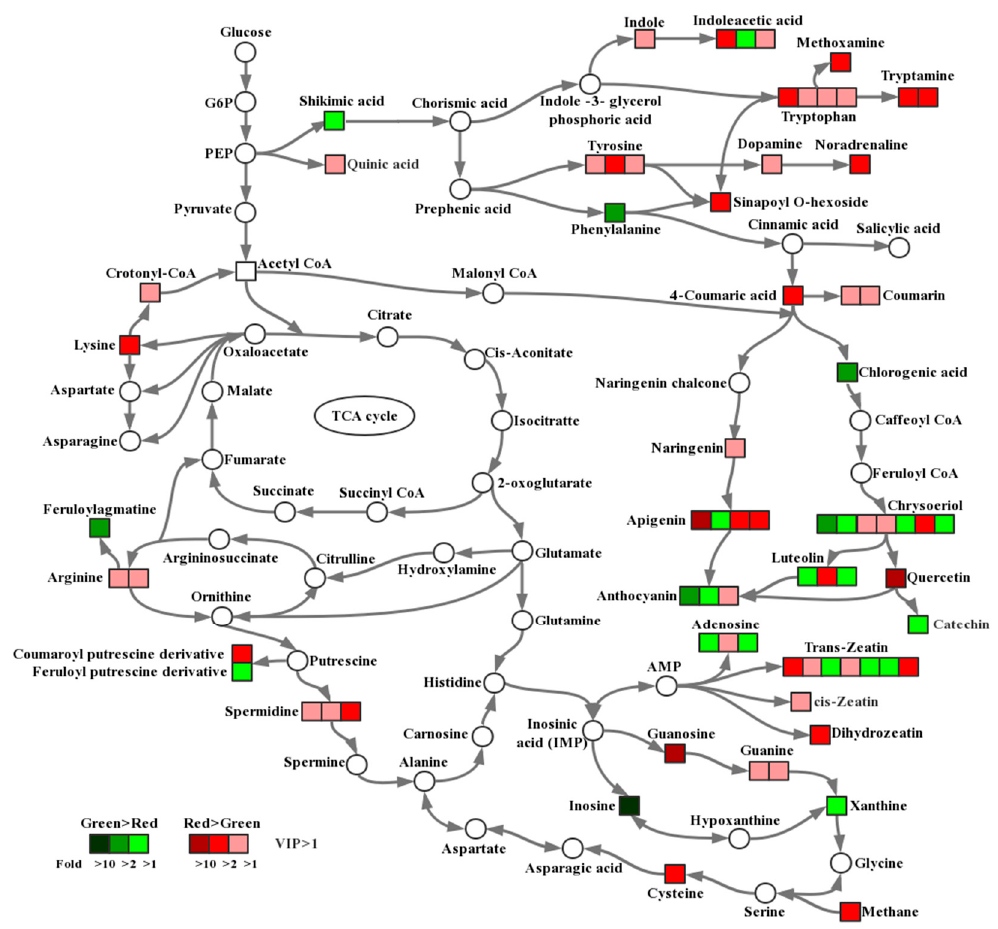
Figure 4. Comparison of metabolite accumulation in different pathways between green and red pods. Significant metabolite changes (VIP > 1) observed in red pods versus green pods are shown in the metabolic map. Metabolites shown as squares were detected in this study, whereas those shown as circles were undetectable. The squares in red indicate that the content of the metabolite in red pods was higher than that in green pods, and the darker the color, the larger the difference. Similarly, the squares in green indicate that the content of the metabolite in green pods was higher than that in red pods, and the darker the color, the larger the difference. The level of significance was set at VIP > 1.